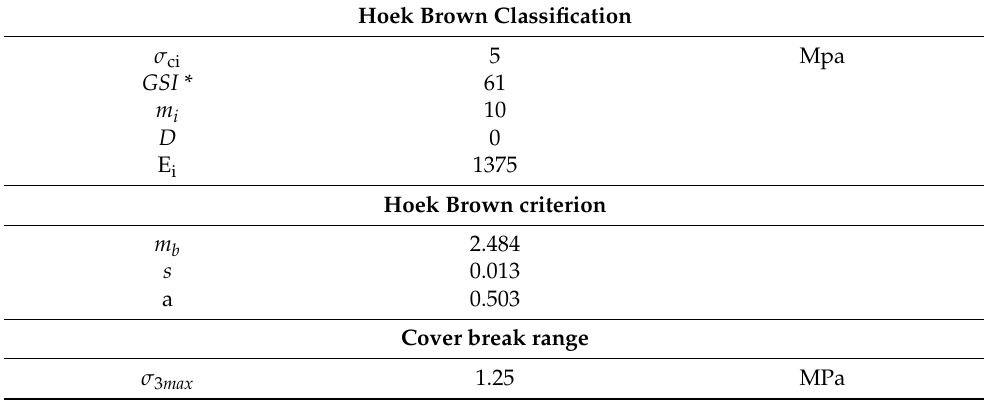
Table A3. Rock mass resistivity